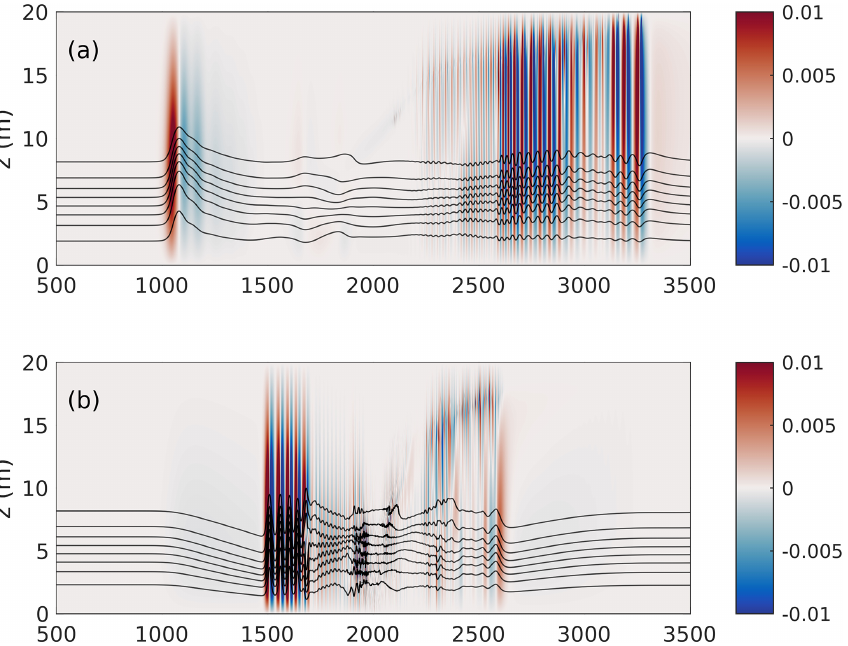
Figure 13. The vertical component of velocity (shaded) saturated at ± 0 . 01ms − 1 with eight isolines of density superimposed at t = 5400s. (a) Case NO DJL 1B and (b) case NO DJL 1BF (polarity reversal).